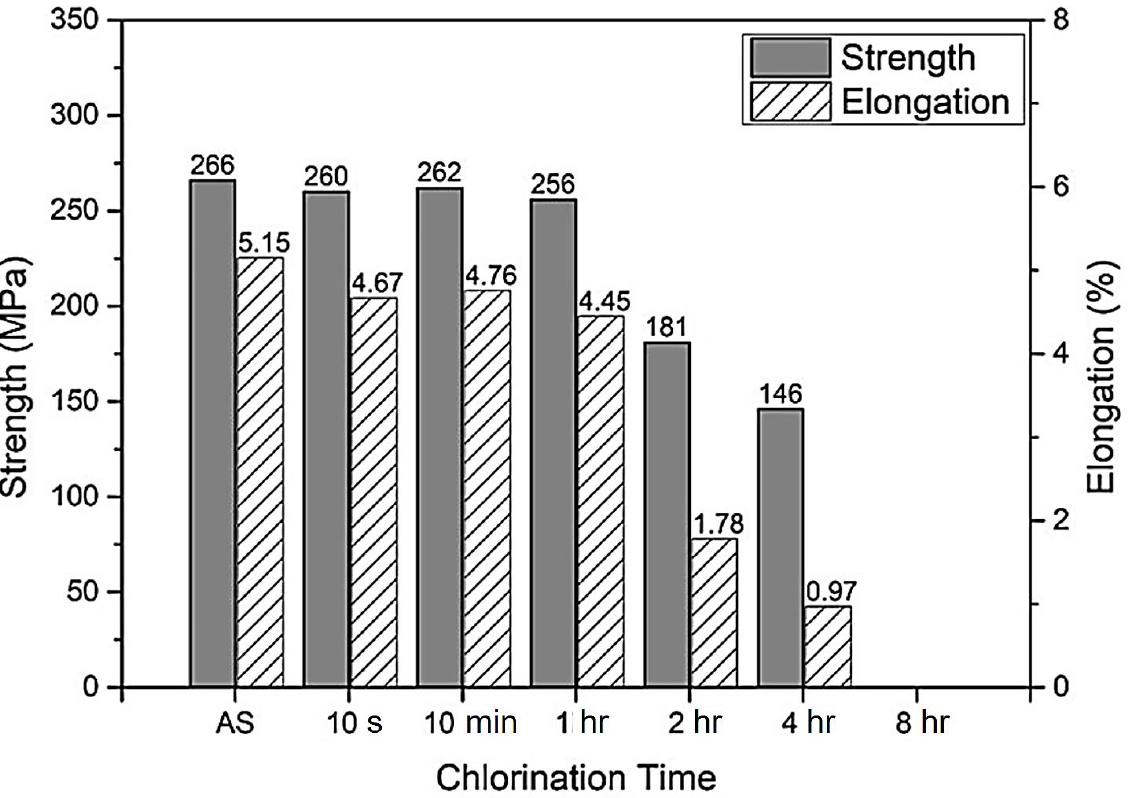
Figure 1. Changes in tensile strength and elongation of the APAP wires after immersion in saturated sodium chloride solution. (The tensile data were the average of five tests).